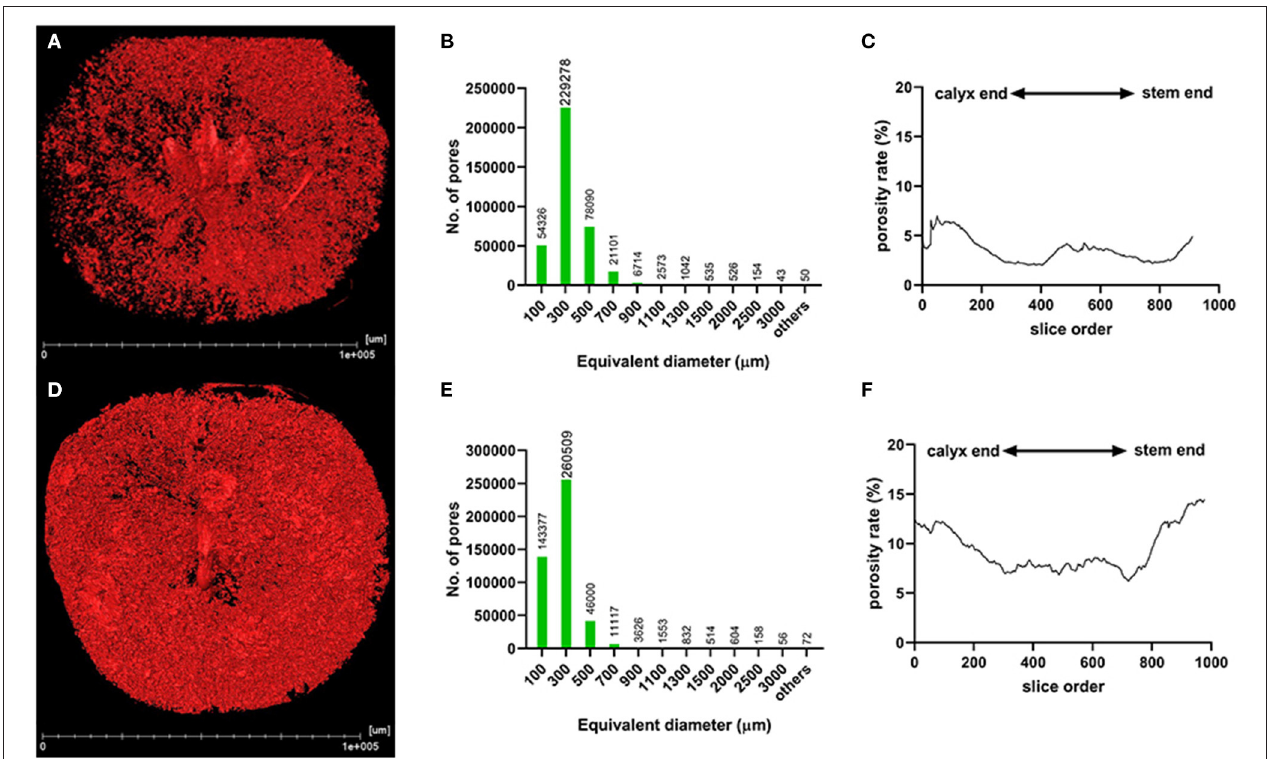
FIGURE 3 | Microstructure analysis of whole “Akizuki” fruit at harvesttime. (A,D) Renderings of X-ray scanning of healthy and cork spotted fruit, respectively. Red dots represent pores based on the grayscale value threshold. (B,E) Histograms of the pore number and size in healthy and cork spotted fruit, respectively. (C,F) Porosity analysis of healthy and cork spotted fruit, respectively. The segmentation of the X-ray scanning data was conducted from the calyx-end to the stem-end of the fruit.